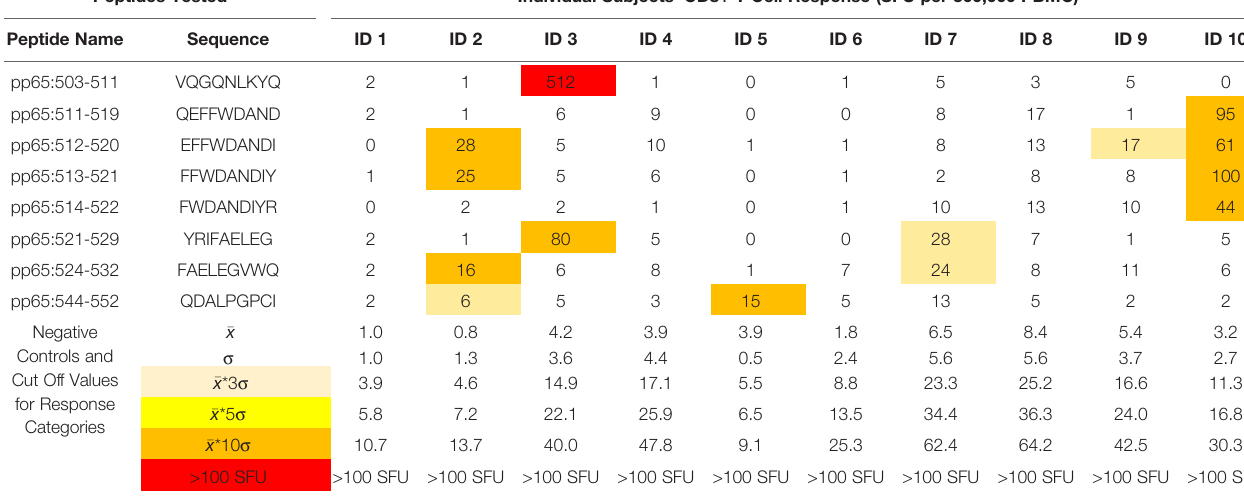
TABLE 1 | Continued Peptides Tested